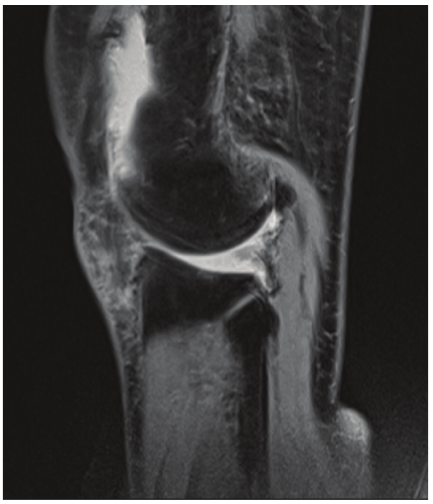
Figure 5: MRI of Case 2 (T2 weighted image). The middle and posterior portions of the lateral meniscus are